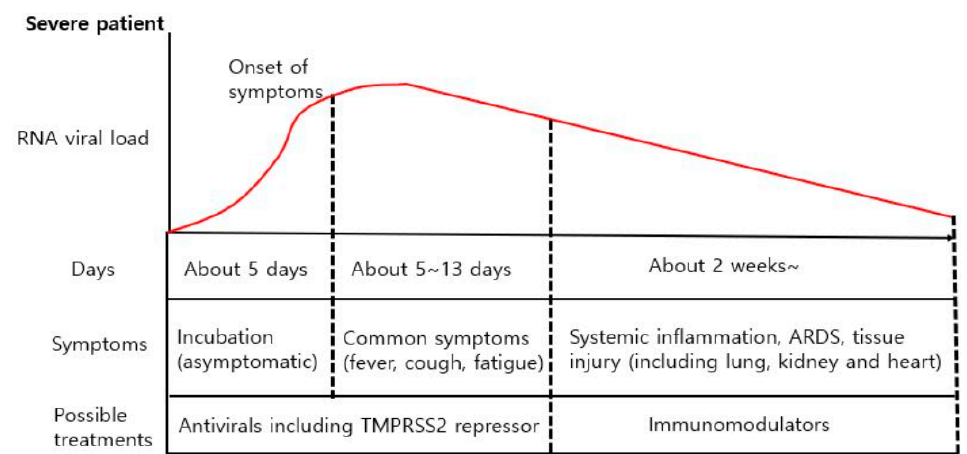
Figure 5. Possible treatment strategies for progressive symptoms in patients with severe COVID-19. The incubation period for COVID-19 patients is about 5~6 days (but could be up to 14 days). After the incubation period, patients have common and relatively mild symptoms, including fever and cough. About 80% of COVID-19 patients recover spontaneously, but about 20% develop serious symptoms such as increased inflammation markers and pneumonia. Persistent inflammation and delayed virus removal can cause serious tissue damage to the lungs, kidneys, and heart, which can be fatal. Therefore, immunomodulators should be administered to severely ill